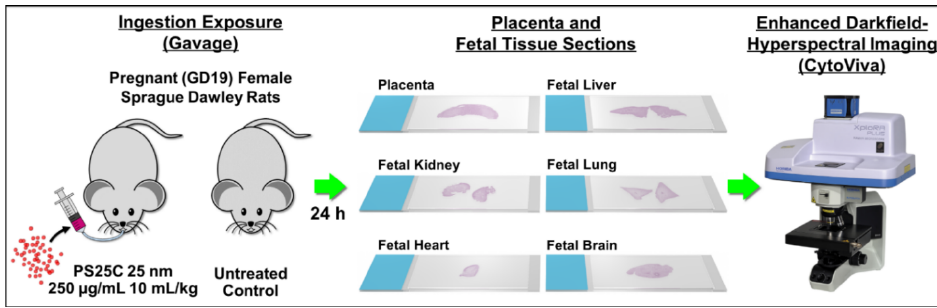
Figure 1. Study design